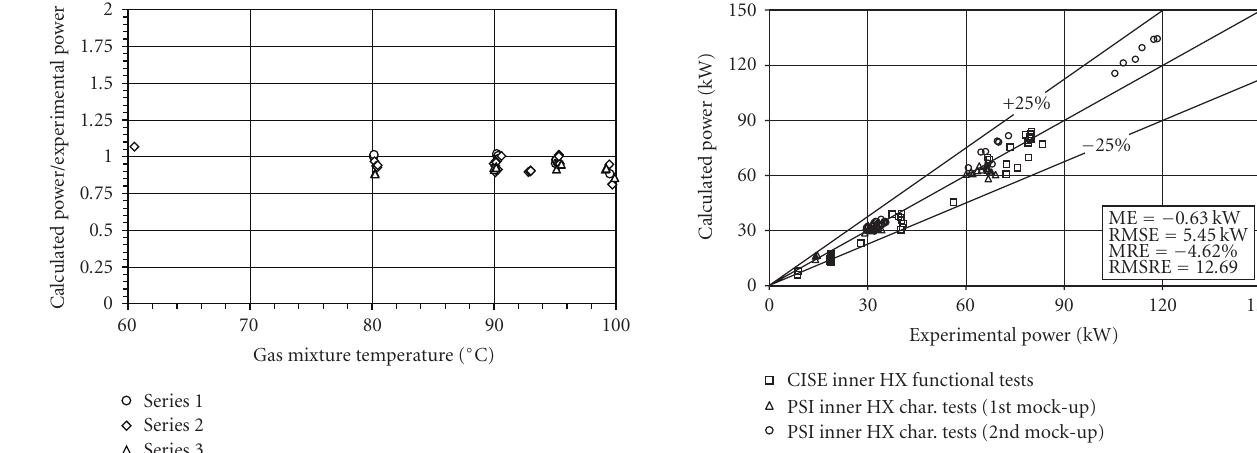
Figure 8: Results obtained for natural convection condensation on single-finned tubes by the Tsubouchi and Masuda model [34].